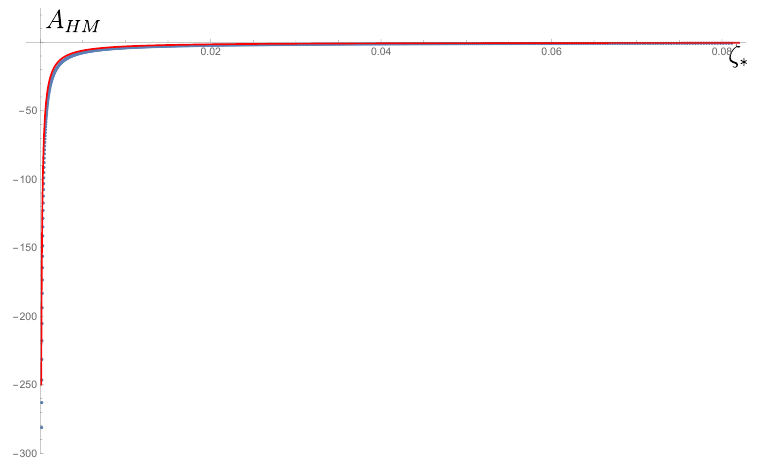
Figure 16 . Area of the HM surface as a function of ζ ∗ with u h = 1 . The red curve is what we expect for the near-horizon region (small ζ the data roughly matches the theory, but for some large enough ζ and we should not expect the data to match. It is not visible, but there is a small error in the “large” ζ ∗ region.